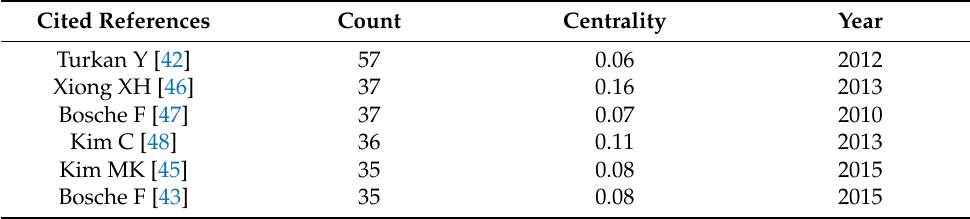
Table 3. List of Top 5 high-frequency cited papers and related network data.